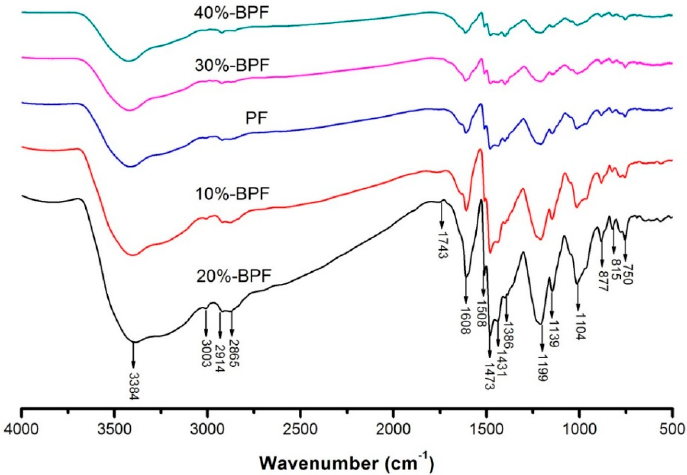
Figure 1 . FTIR spectrum of various BPF resins. Figure 1. FTIR spectrum of various BPF